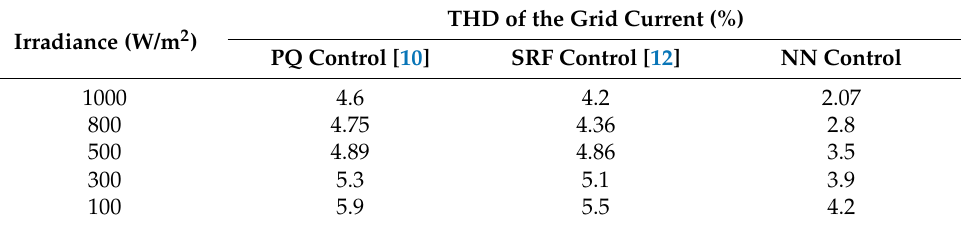
Table 1. Comparisons Grid current THD for NN controller with PQ and SRF control for various irradiance conditions.